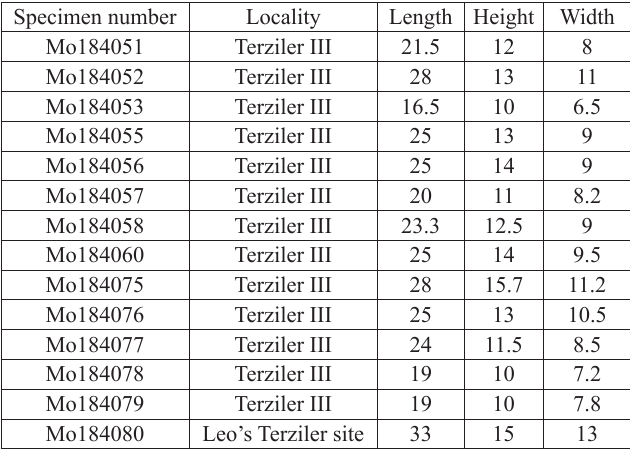
Table 1. Measurements (in mm) of Terzileria gregaria sp.